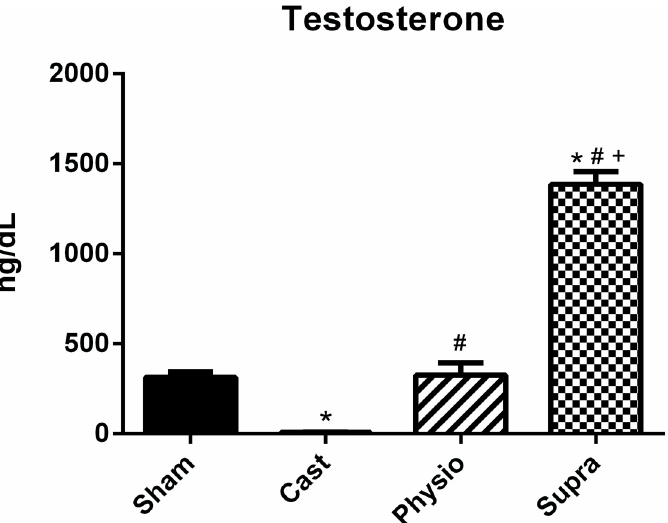
Fig 4. Hormone level. Testosterone in the SHAM (n = 15), CAST (n = 15); PHYSIO (n = 17), and SUPRA (n = 16) groups. Data are expressed as the mean ± SEM. * p < 0.05 compared with the SHAM group, #p < 0.05 compared with the CAST group, and +p < 0.05 compared with the PHYSIO